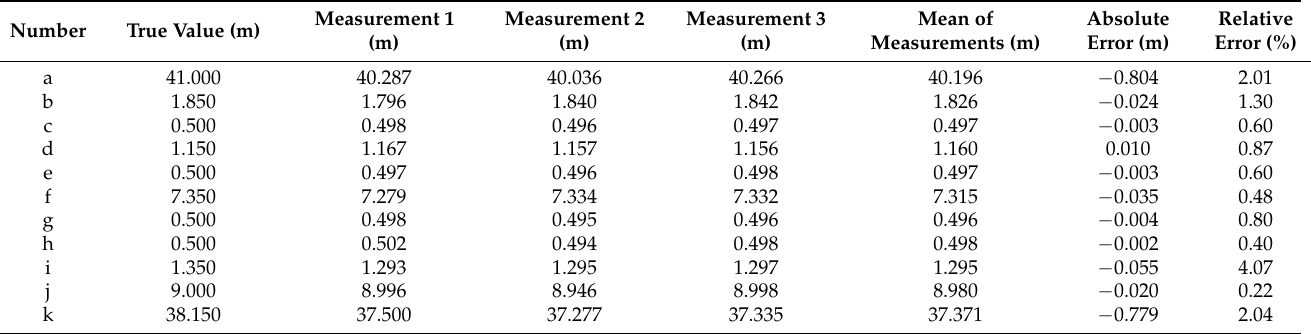
Table 4. Mapping data in simulation scene.